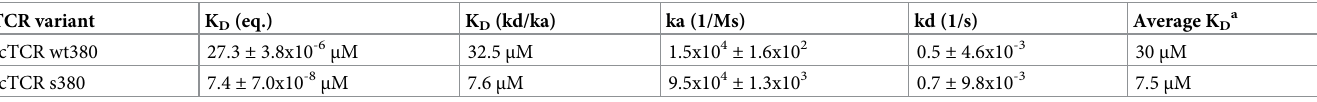
Table 3. SPR-derived kinetic and equilibrium